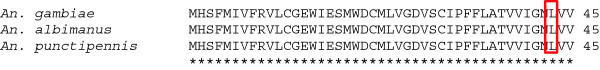
Amino acid sequence comparison of kdr region of Anopheles albimanus with other anopheline species. The sequence of the segment 6 of domain II of the VGSC gene of An. albimanus was compared to An. gambiae [GenBank: CAA73920] and An. punctipennis [GenBank: AAP60053]. Identical positions are indicated by an asterisk and mutation site (codon 1014) is enclosed by a red box. The amino acid at the mutation site corresponds to the pyrethroid and DDT susceptible (wild-type) genotypes.